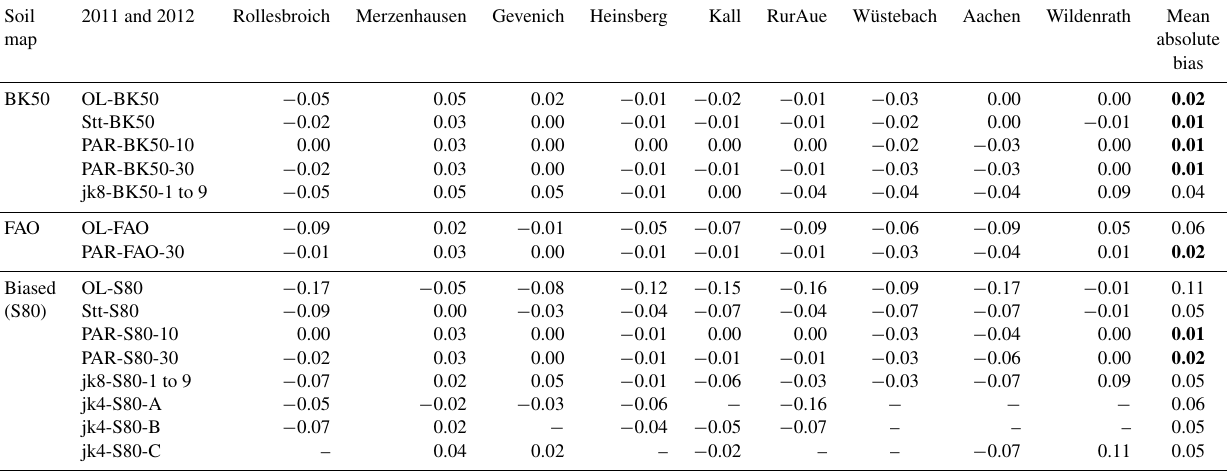
Table A3. Bias (cm 3 cm 3 ) at CRNS sites for open loop, data assimilation and jackknife simulations compared to CRNS SWC retrievals for the data assimilation period (2011 and 2012). For jackknife experiments (21 in total) only the bias of the omitted sites is reported. The best cases are marked in bold.